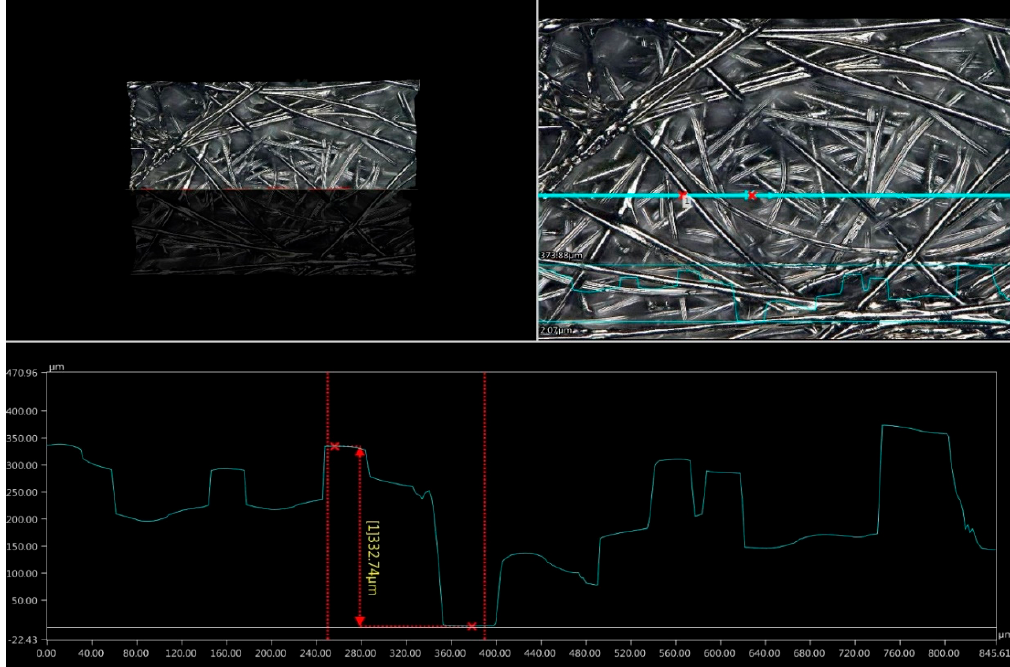
Figure 8. The structure and surface profile of the textile electrode produced in the PVD process on a fibrous substrate.